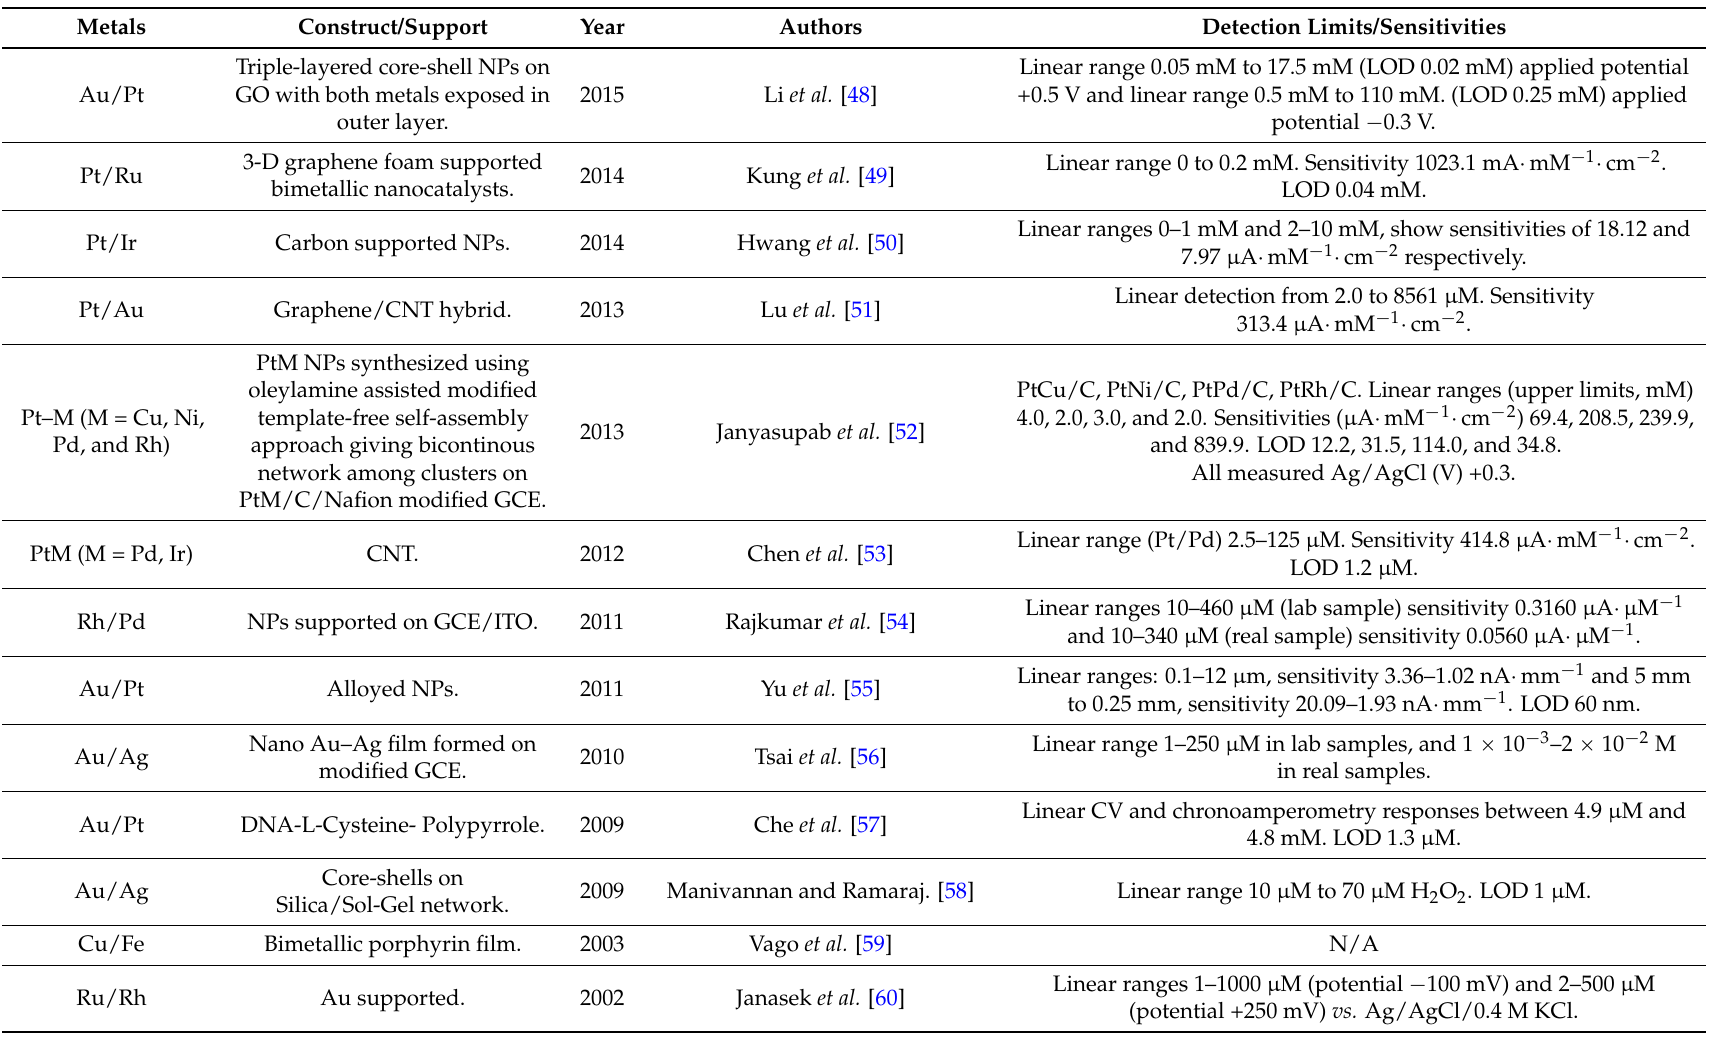
Table 1. Metals and constructs used for H 2 O 2 sensing: see also Section 2.3, combined H 2 O 2 and glucose